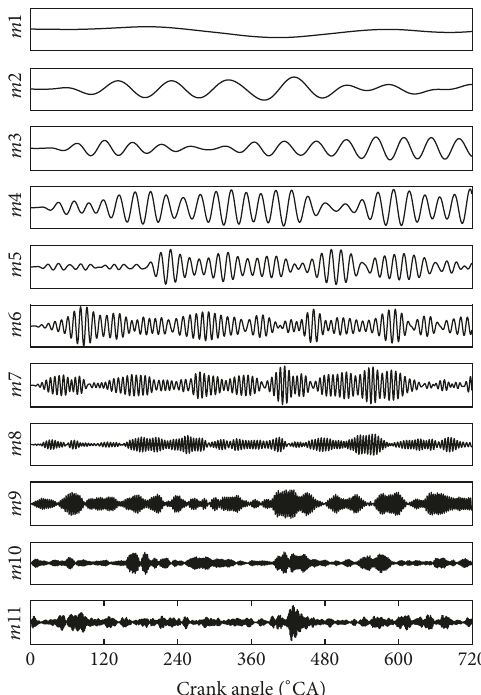
Figure 12: Decomposition results by the Gammatone filter bank.